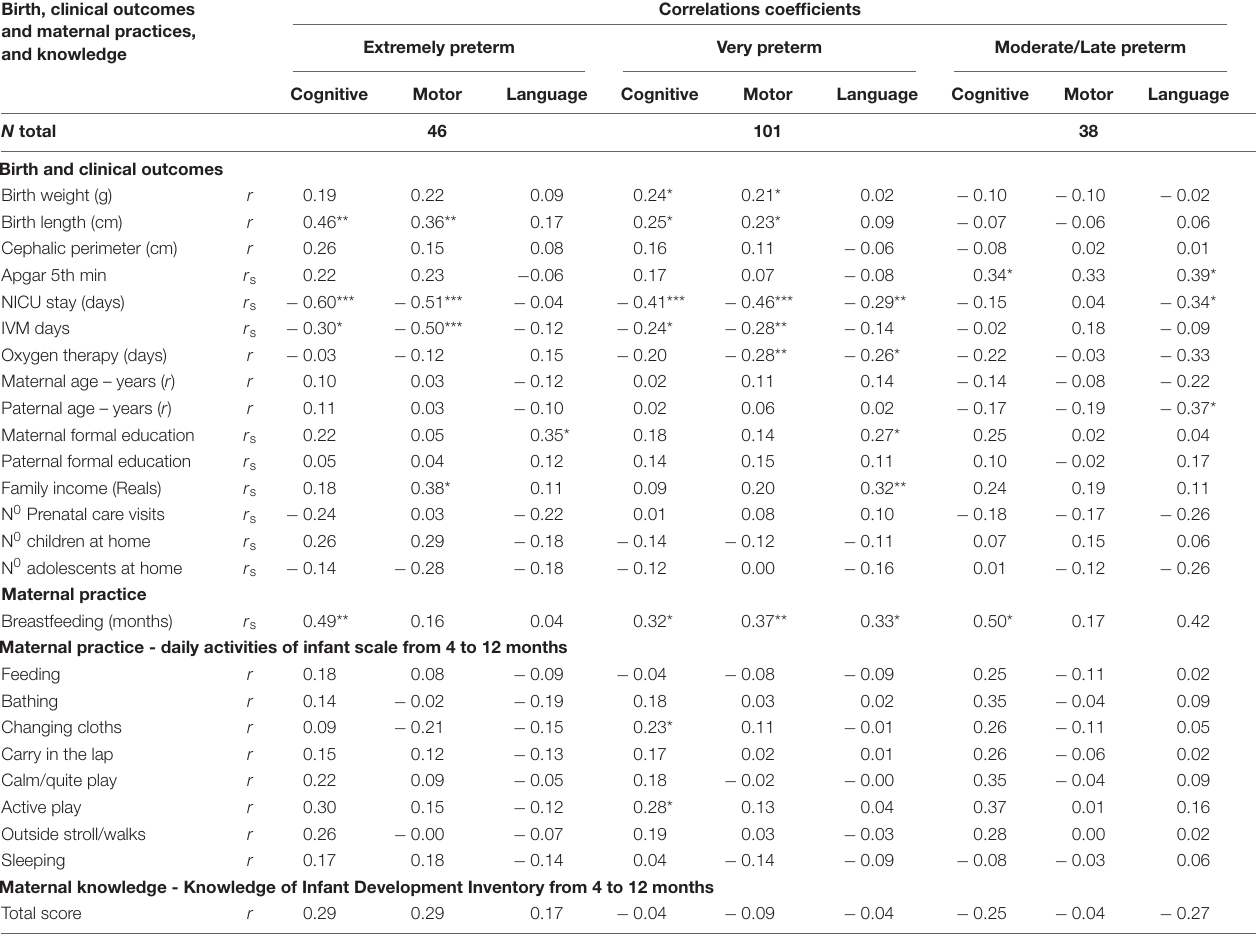
TABLE 6 | Associations: birth, clinical outcomes, maternal practices, and knowledge. Birth, clinical outcomes and maternal practices, and